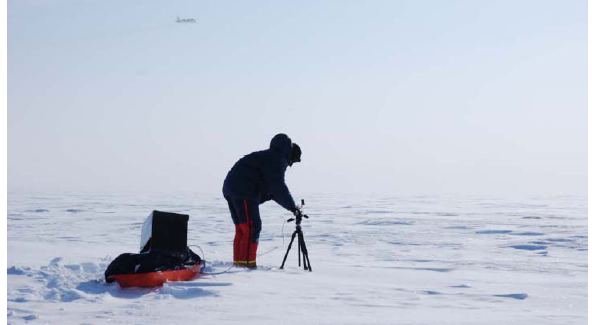
Figure 1. Spectral albedo measurements on Elson Lagoon on April 15, 2008, with the P-3B airplane in the background. The leveled cosine collector is rotated to collect light from upward and downward hemispheres sequentially. The light is carried through a fiber-optic guide to the ASD spectral radiometer and its computer, which are mounted on the sled.